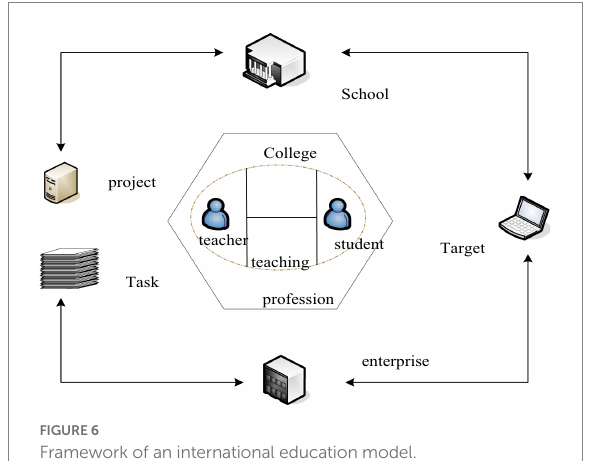
FIGURE 6 Framework of an international education model.